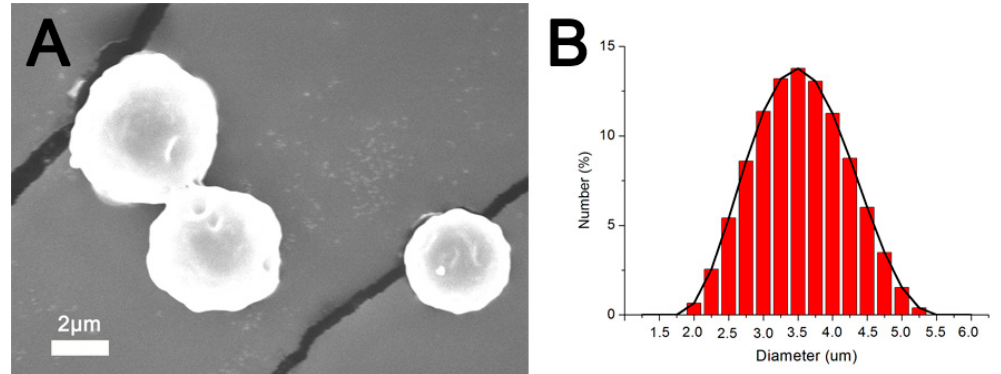
Figure 2. Vancomycin-embedded poly(lactide- co -glycolide acid) microparticle (VMP). ( A ) Scanning electron microscopy (SEM) image of VMPs (x 6,000) and ( B ) particle size distribution.